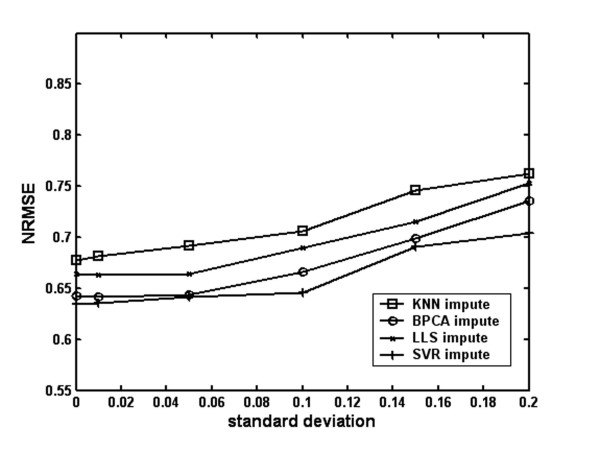
Comparison of the NRMSEs with respect to noise levels. Artificial noise, with normal distribution of a mean μ = 0 and various standard deviations (σ = 0.01,0.05,0.1,0.15,0.2), were added to data C to construct the five noisy datasets.